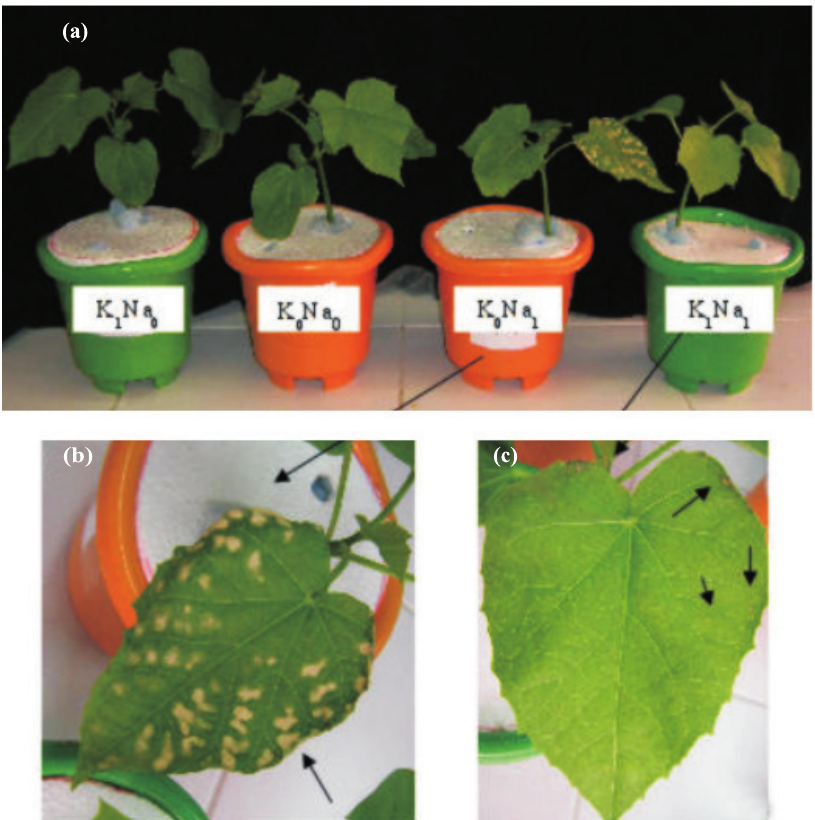
figura 5. (a) crescimento das plantas nos diferentes tratamentos. K 0 : ausência de potássio; K 1 : 10 mmol l -1 de K; na 0 : ausência de sódio; e na 1 : 50 mmol l -1 de na na solução nutritiva; (b) e (c), sintomas de toxidez em folhas de plantas jovens de pinhão-manso causados por excesso de sais por um período de oito